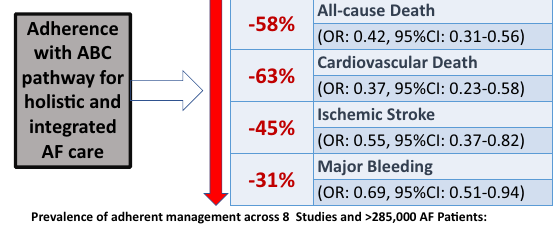
Fig. 3 Impact of ABC pathway adherence on clinical